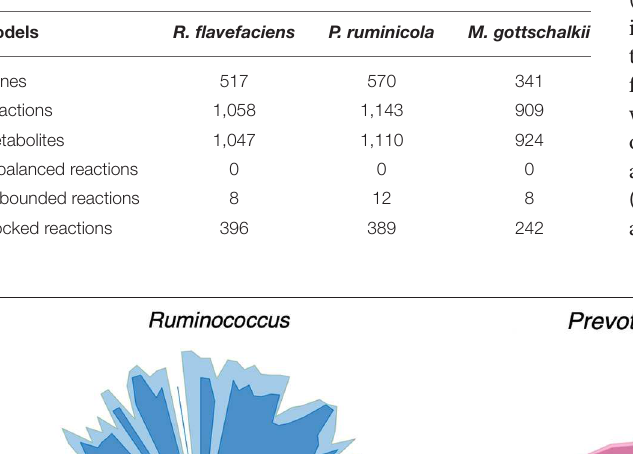
Frontiers in Microbiology |